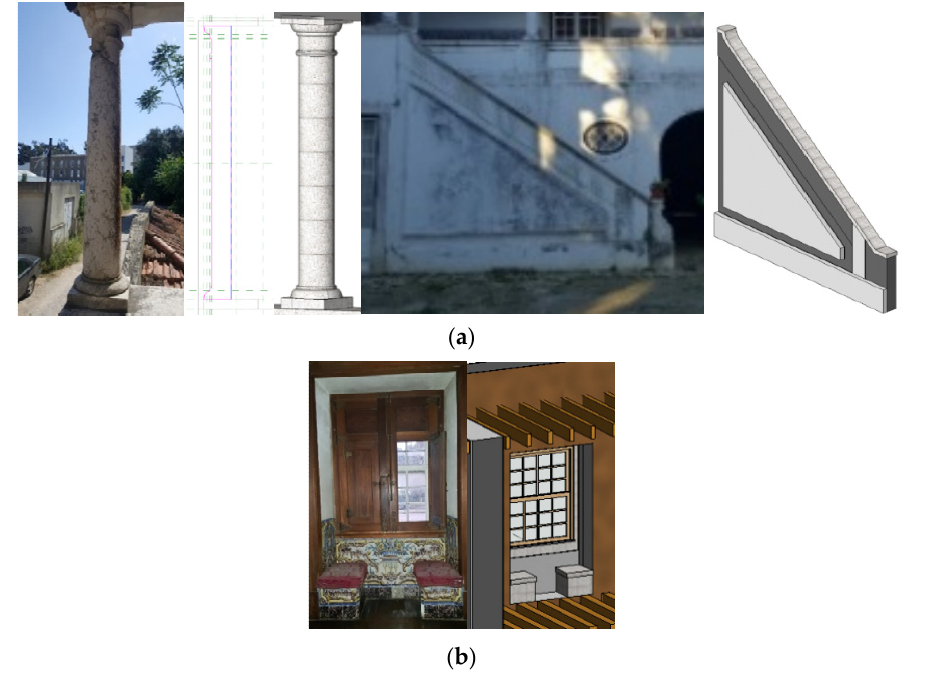
Figure 6. Real geometry and parametric objects: ( a ) outdoor ( b ) indoor.